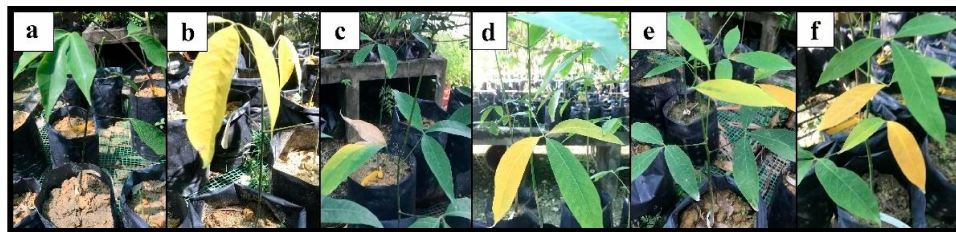
Figure 5. Examples of above-ground symptoms on rubber seedlings after six months of treatments with ( a ) T1, a plant without any pretreatment and Rigidoporus microporus inoculation (the negative control); ( b ) T2, a plant inoculated with Rigidoporus microporus but without any pretreatment (the positive control); ( c ) T3, a plant pretreated with Trichoderma asperellum and inoculated with Rigidoporus microporus; ( d ) T4, a plant pretreated with Trichoderma spirale and inoculated with Rigidoporus microporus; ( e ) T5, a plant pretreated with the combination Trichoderma asperellum + Trichoderma spirale and inoculated with Rigidoporus microporus; and ( f ) a T6, plant pretreated with propiconazole and inoculated with Rigidoporus microporus.